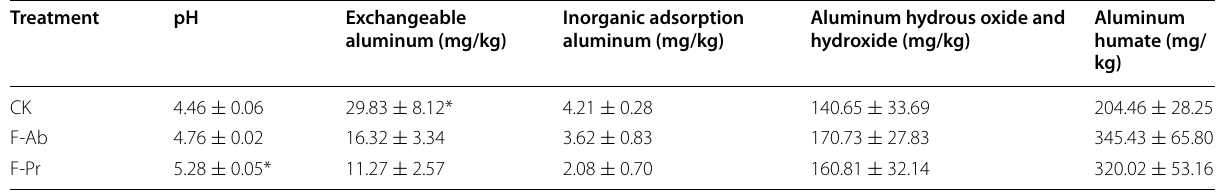
The star (*) indicates significant difference between treatment at 0.05 level CK control, F-Ab the vegetative branches cover treatment, F-Pr the fruit-bearing branches cover treatment